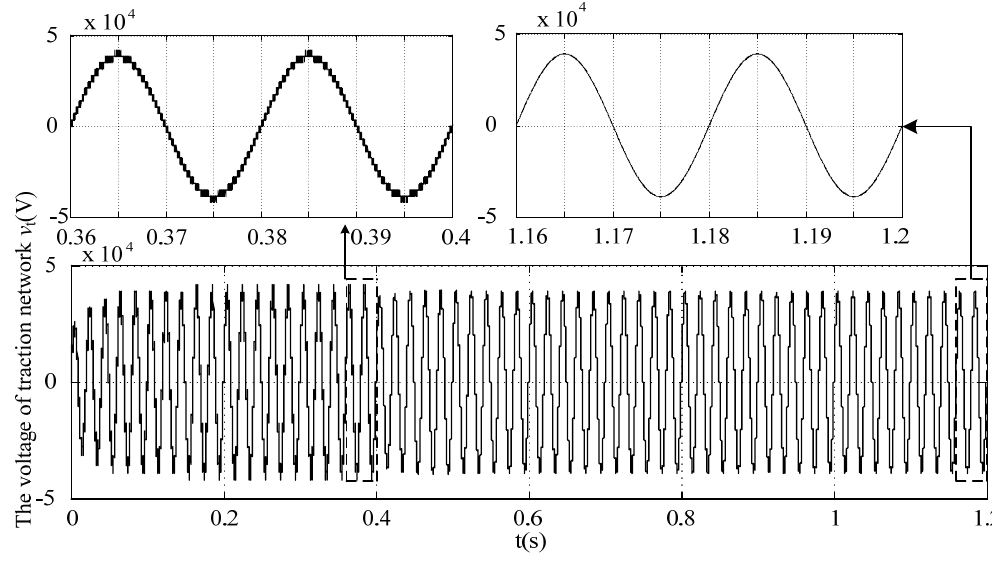
Figure 11. The voltage of traction